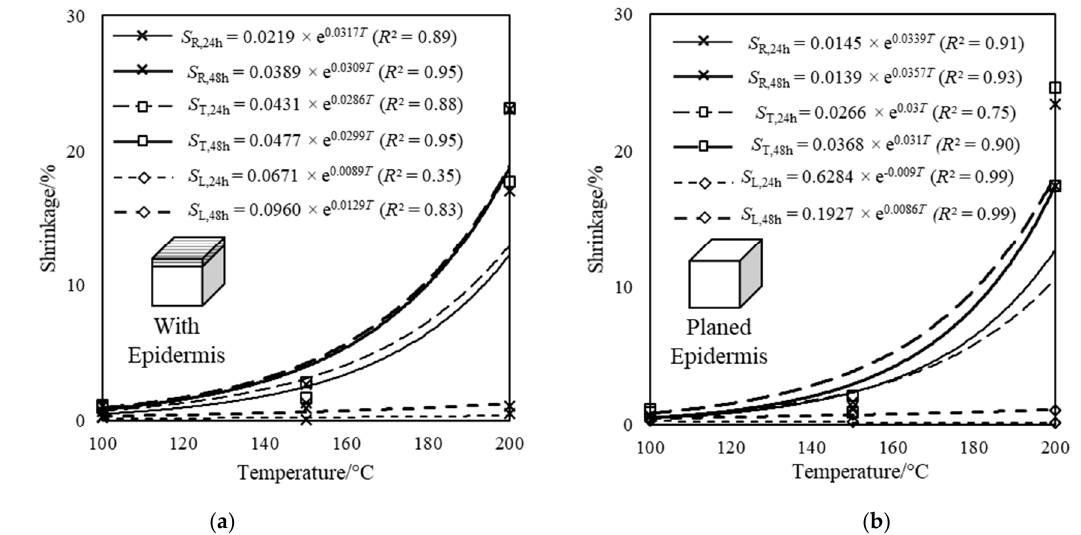
Figure 6. The dimensional changes due to shrinkage (including R 2 values) in radial, tangential and longitudinal directions of test specimen: ( a ) with epidermis and ( b ) with planed epidermis subjected to heat treatment at three different temperatures for 24- and 48-h duration.